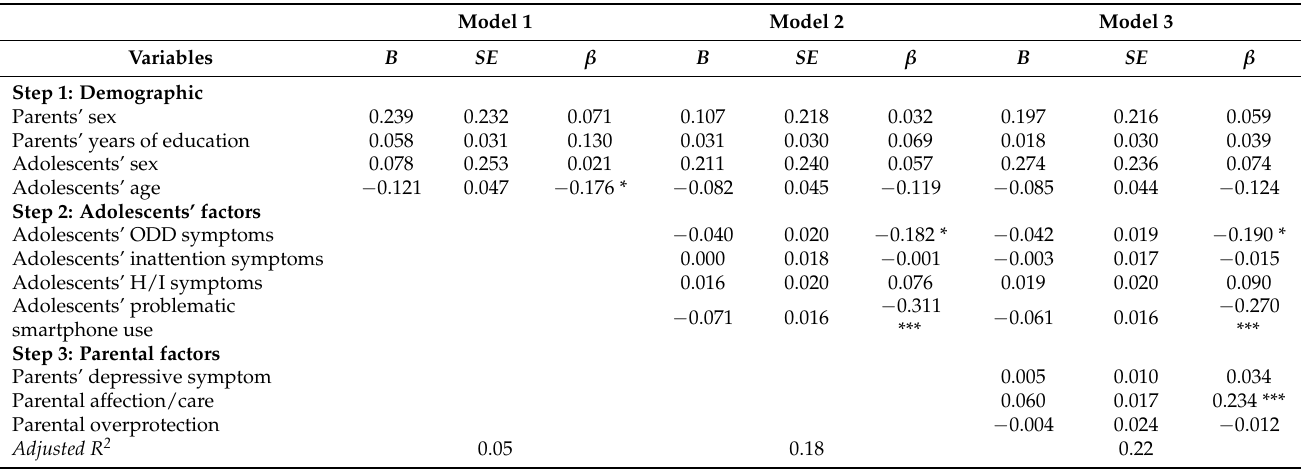
Table 2. Factors Related to Parental Efficacy in Managing Adolescent Smartphone Use: Hierarchical Regression Analysis